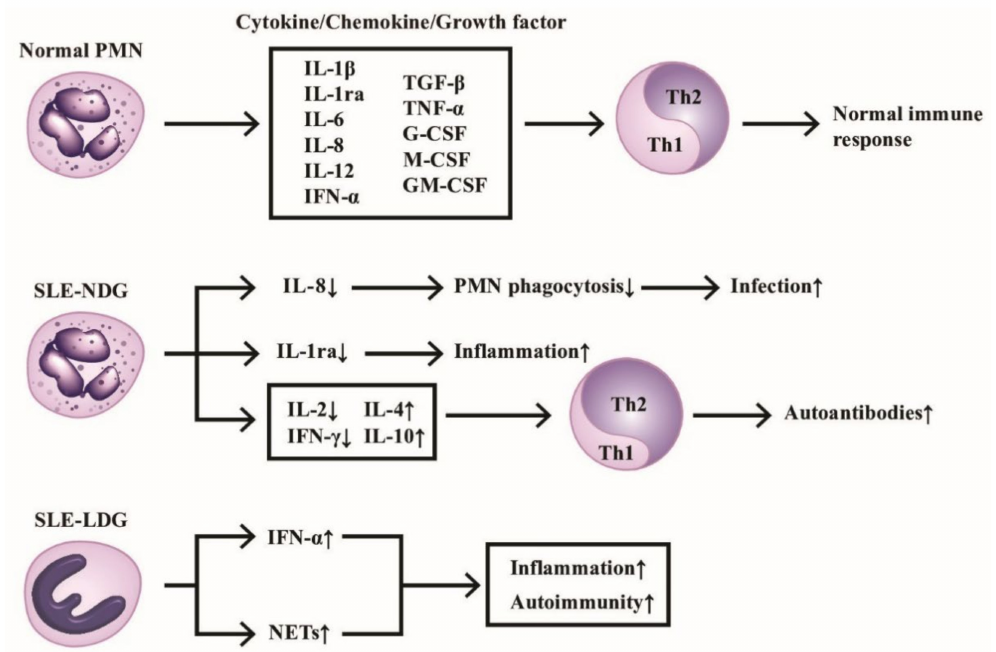
Figure 1. The production of cytokines/chemokines/growth factors by PMNs from normal, normal density (SLE-NDG), and low density (SLE-LDG) granulocytes of patients with SLE. The effects of these mediators on Th1/Th2 differentiation and pathological roles are summarized. IL-1ra: IL-1 receptor antagonist, NETs: neutrophil extracellular traps, CSF: colony- stimulating factor. Th: helper T; GM-CSF: granulocyte-macrophage colony stimulating factor; IFN: interferon; IL: interleukin; TGF; transforming growth factor; TNF: tumor necrosis factor. ↑ denotes increase, ↓ denotes